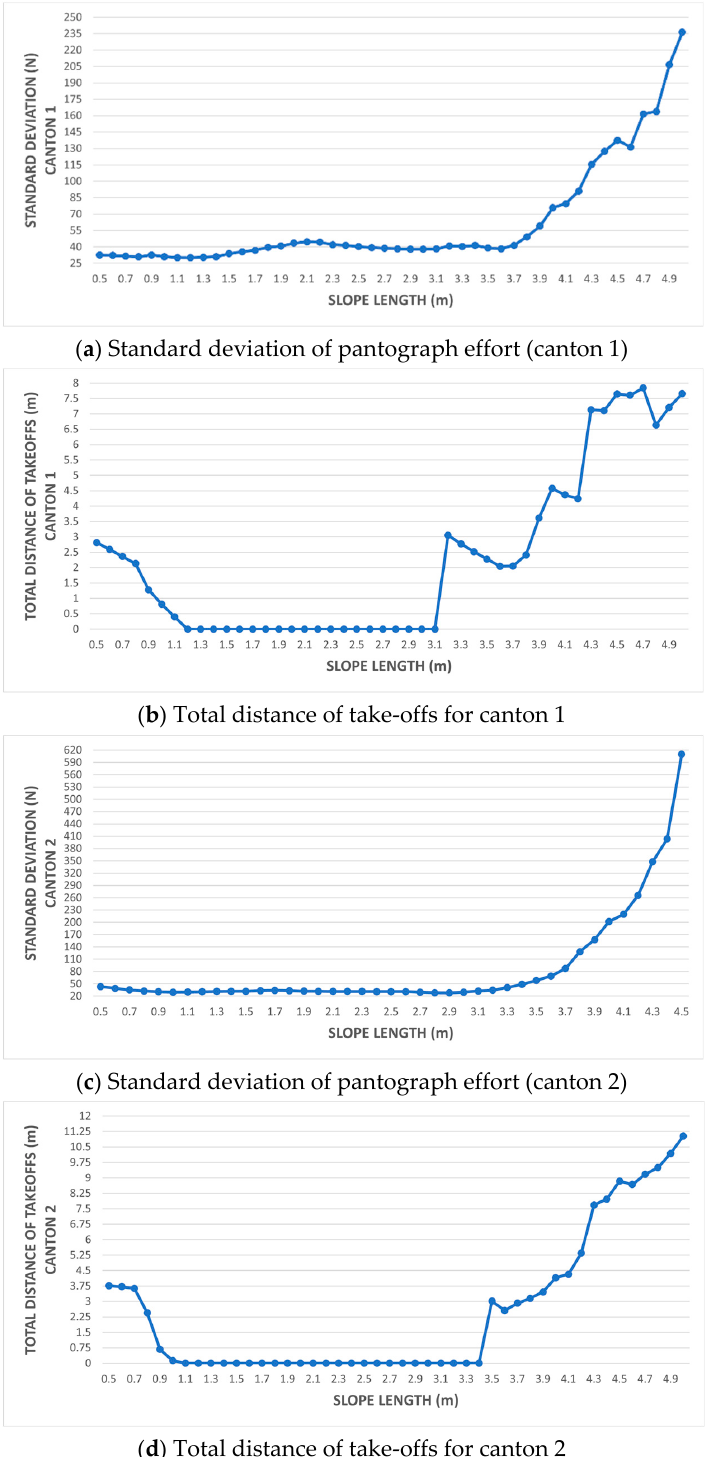
Figure 13. Graphs of simulation 3 per cantons. Variation of the length of the overlapping span in the range of 0.5 to 5 m and height 0 of the slope. Normal spans are 10 m long. ( a ) Standard deviation of pantograph effort (canton 1), ( b ) total distances of take-offs for canton 1, ( c ) standard deviation of pantograph effort (canton 2), and ( d ) total distances of take-offs for canton